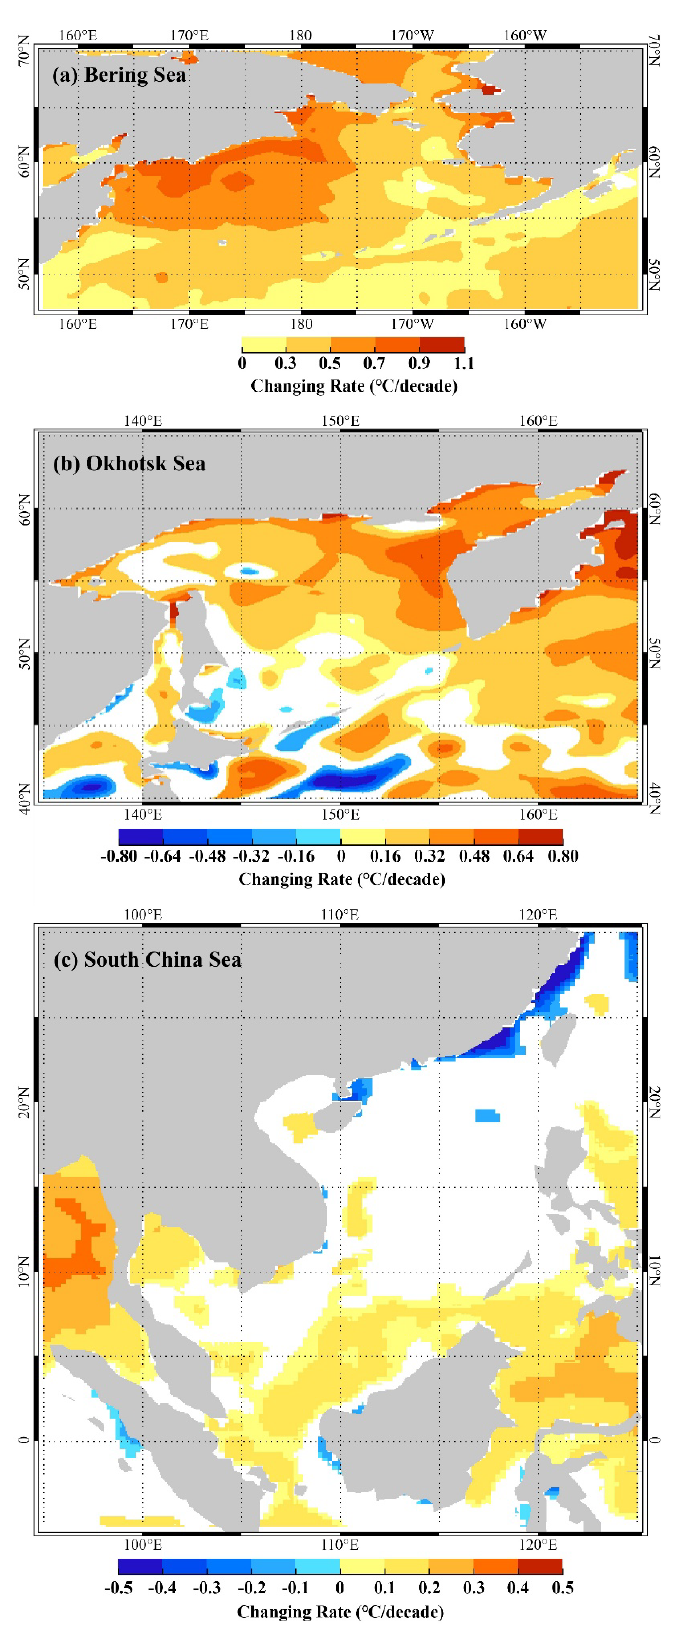
Figure 3. SST trends in the ( a ) Bering, ( b ) Okhotsk, and ( c ) South China Seas during 1998–2018 (bright colors show pixels with p < 0.1).